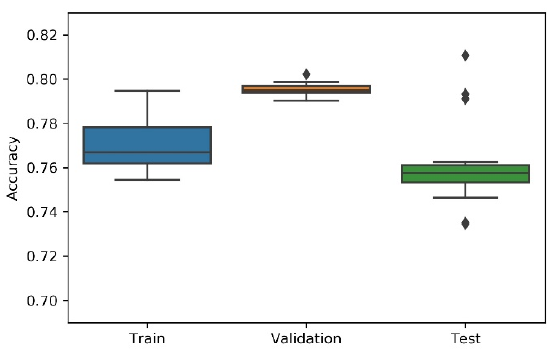
Figure 10. Experiment’s performance for Approach A4 (Random) accuracy (in %).